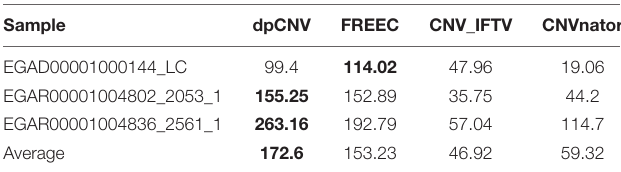
TABLE 1 | Comparison of ODS between dpCNV and three peer methods on real